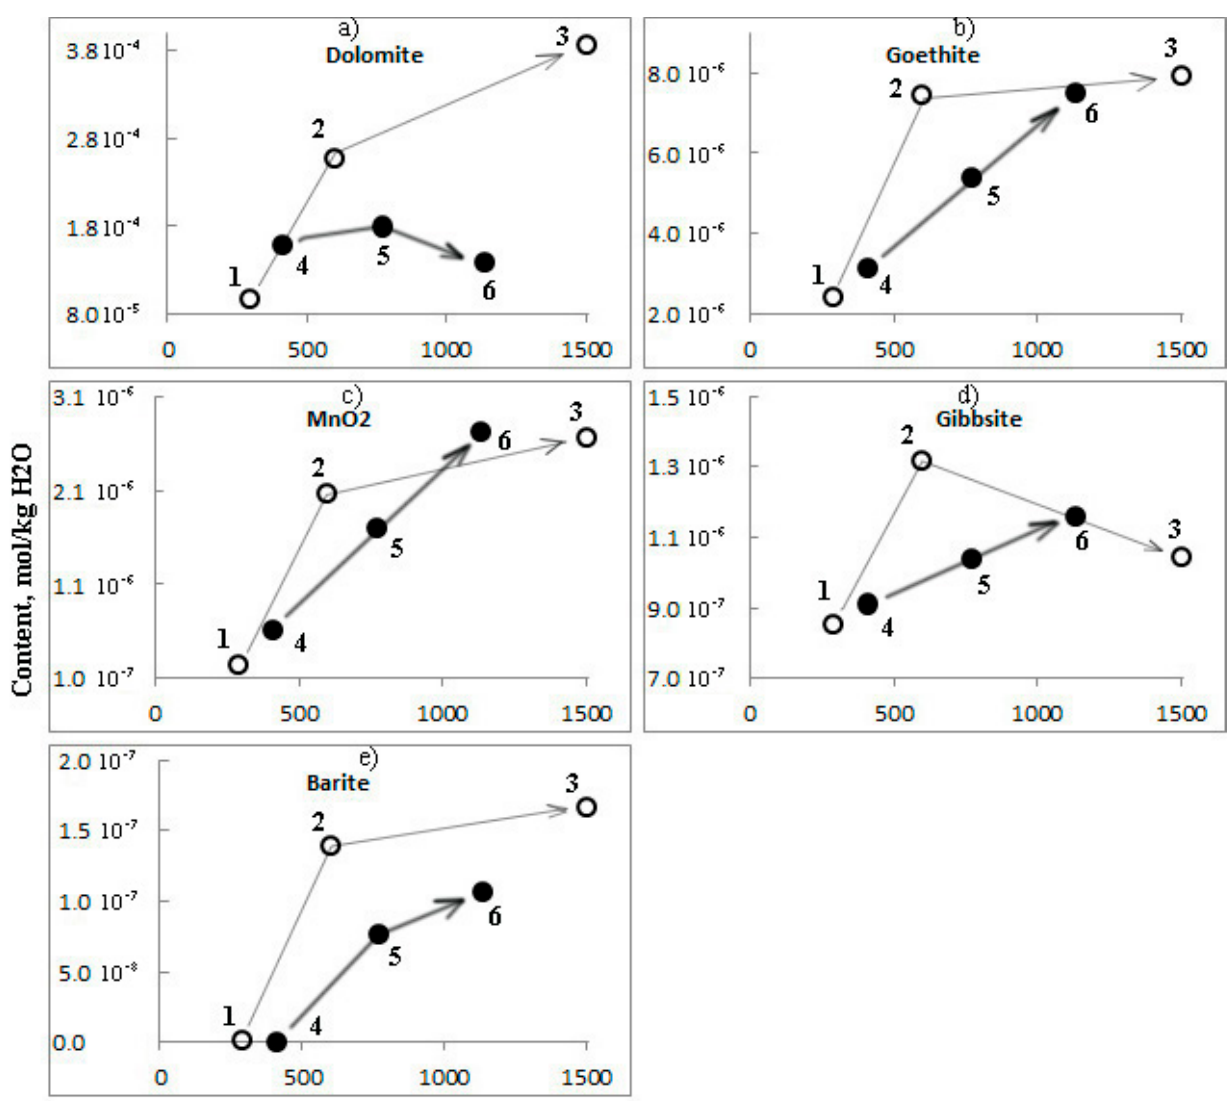
Figure 7. Dependence of changes in concentrations of precipitated minerals from obtained solutions ( a ) Dolomite, ( b ) Goethite, ( c ) MnO 2 , ( d ) Gibbsite, ( e ) Barite according to Scenarios 1–3 (without filling marker) and 4–6 (complete filling of marker) from TDS of these solutions (see Tables 2 and